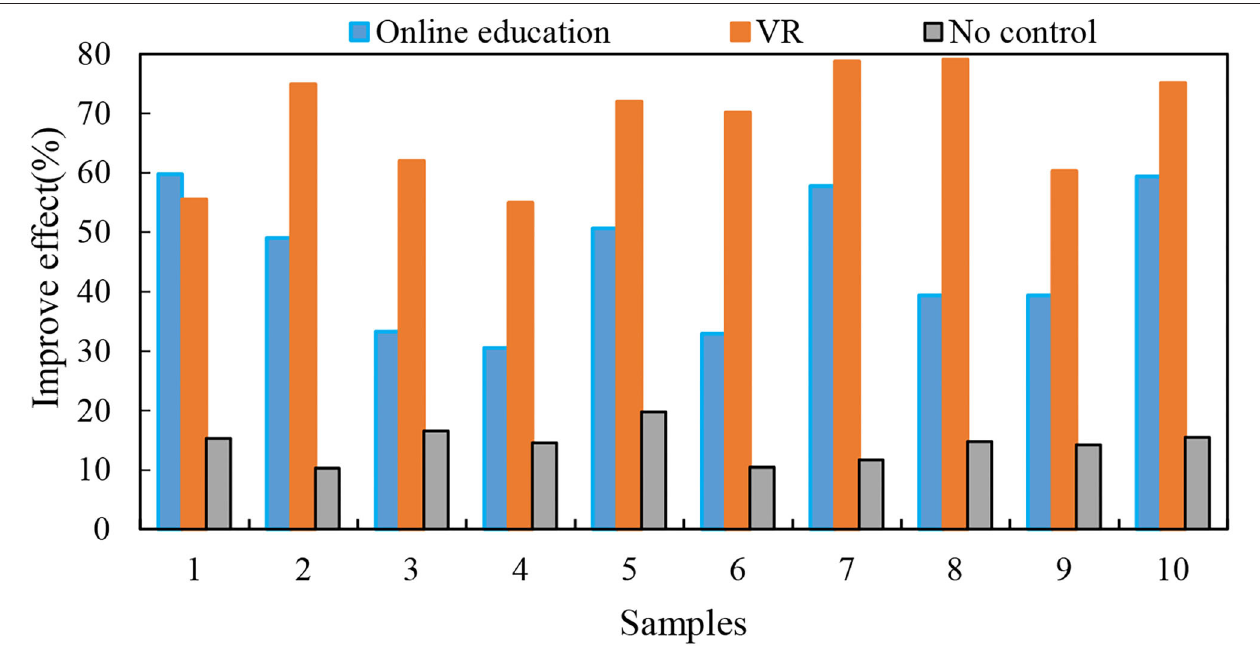
FIGURE 9 | Virtual reality treatment system test results.